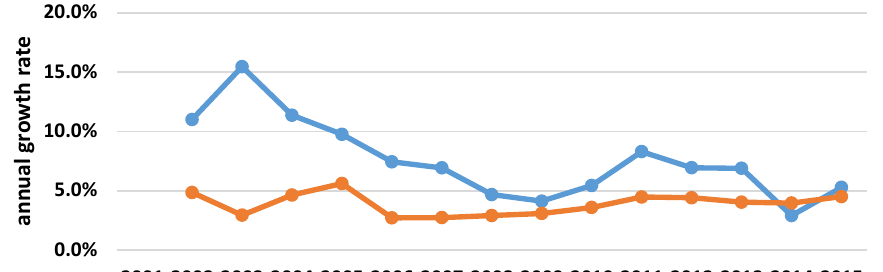
Figure 2. China ’s Building Energy Consumption 2001 – 2015. (Source: 1) Data on total energy consumption, China EBS 2001 – 2015; (Source: 2) Data on total building energy consumption, primary). Table 1. China Energy Consumption growth rate in the three five-year periods.